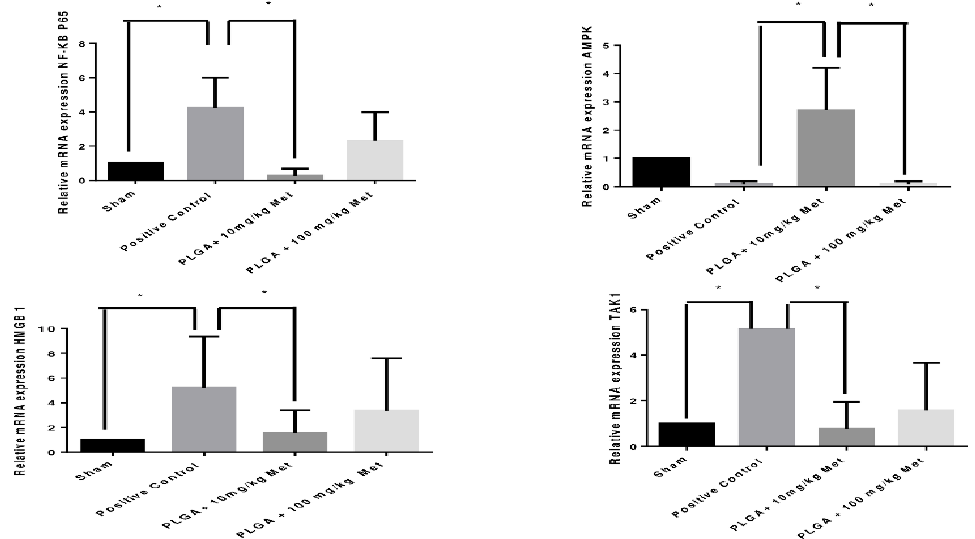
Figure 5. Real-time RT-PCR analysis of gene expression. Met effects on NF- κ B p65 , AMPK, HMGB1 , and TAK-1 mRNA expression in rats. The expression of NF- κ B p65 mRNA was decreased in PLGA + 10 mg/kg compared to the positive control group (* p < 0.05). The expression of AMPK mRNA was increased in PLGA + 10 mg/kg group (* p < 0.05) and decreased in positive group and PLGA + 100 mg/kg group. HMGB1 mRNA levels appeared to be lower in the PLGA + 10 mg/kg group compared to those in the positive control group (* p < 0.05,). TAK-1 appeared to be lower in the PLGA + 10 mg/kg group compared to that in the positive control group (* p < 0.05,) ( n = 5 animals per group; ANOVA test followed by Bonferroni).